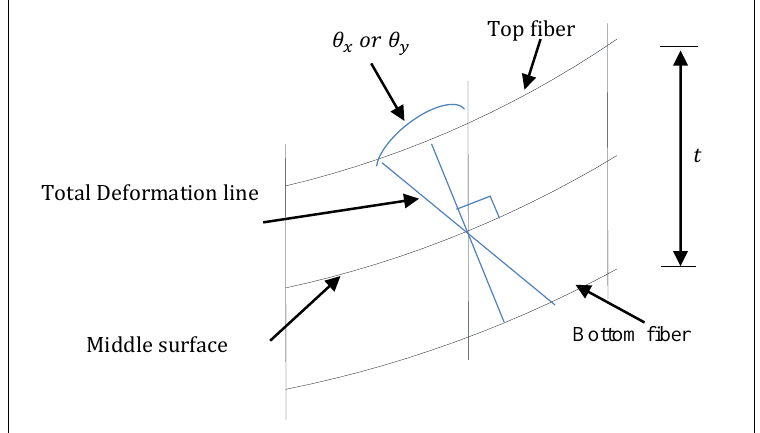
Figure 3. Rotation of x-z (or y-z) section after